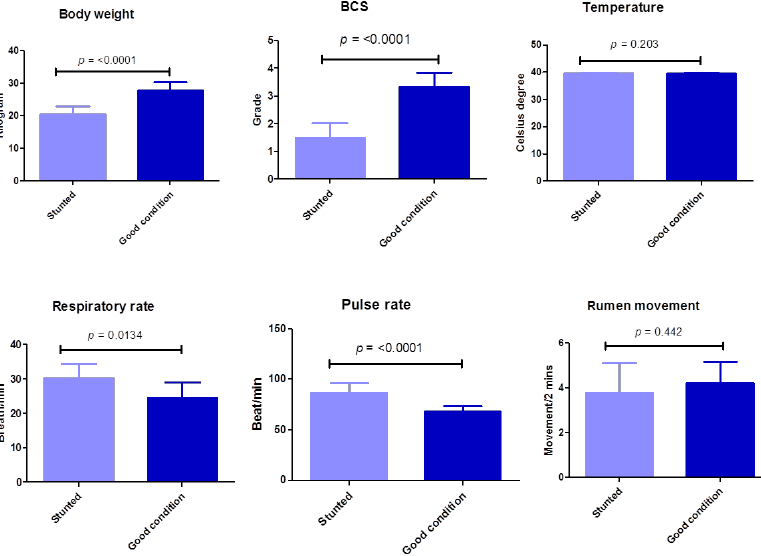
Figure 2. Clinical findings of examined Barki sheep. Body weight, body condition, and systemic parameters were investigated in stunted and good body condition sheep. Each bar represents the mean ± SD with the p -value comparing the two groups using an unpaired Student’s t -test. Signifi- cance at p = <0.05. The results (Figure 3) (Table S1) show the serum biochemical variables between the stunted and control groups. These results revealed the significant decrease ( p = <0.05) in